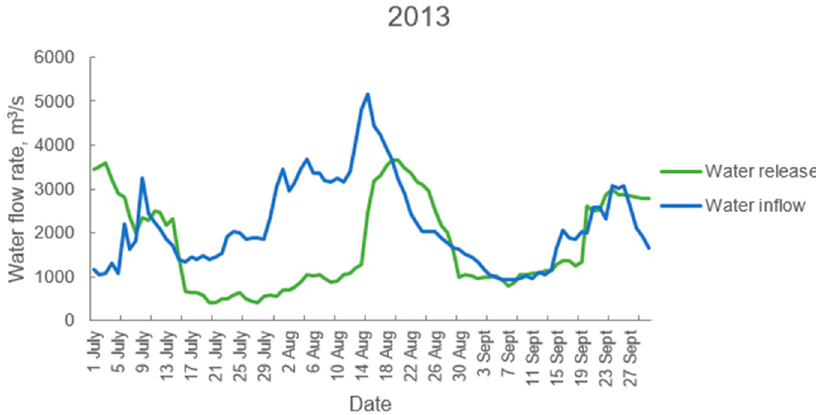
Figure 5. Water inflow to and releases from the Bureya reservoir during the flood of 2013.